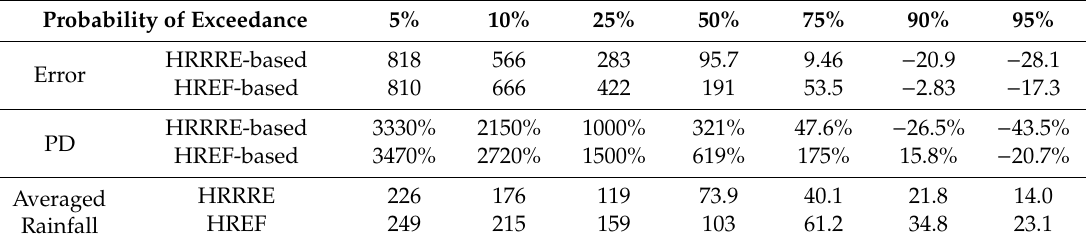
Table 3. Average error in m 3 s − 1 and percent di ff erence (PD) for the probabilistic streamflow predictions and basin-averaged rainfall amounts for 36 h forecasts in mm for all 11 basins and 109 events studied for each probability of exceedance.